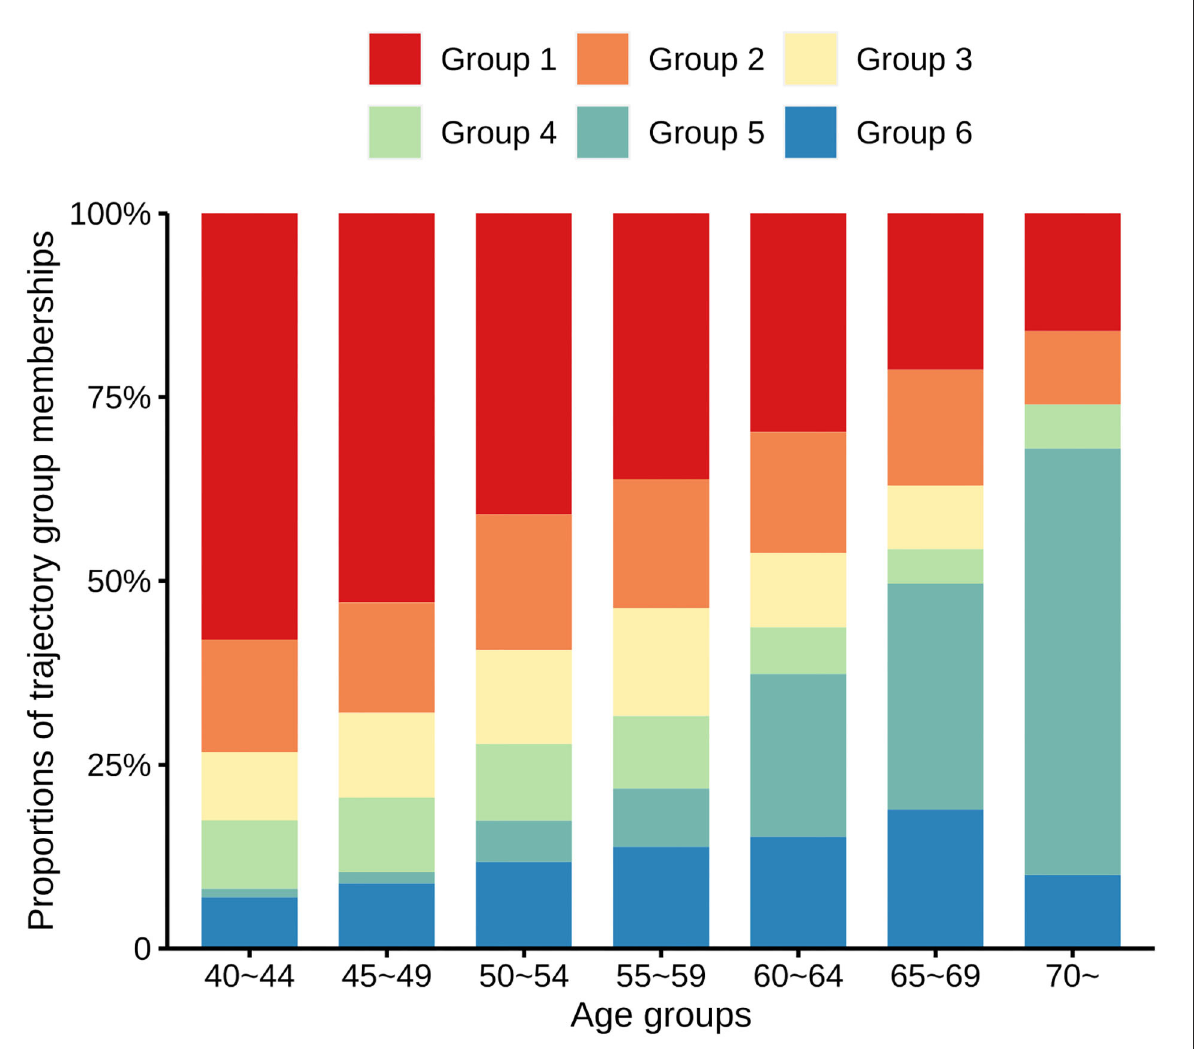
FIGURE2 Proportions of the trajectory group memberships in distinct age groups. Bar charts of different colors represent the proportions of six different multi-trajectories of systolic and diastolic